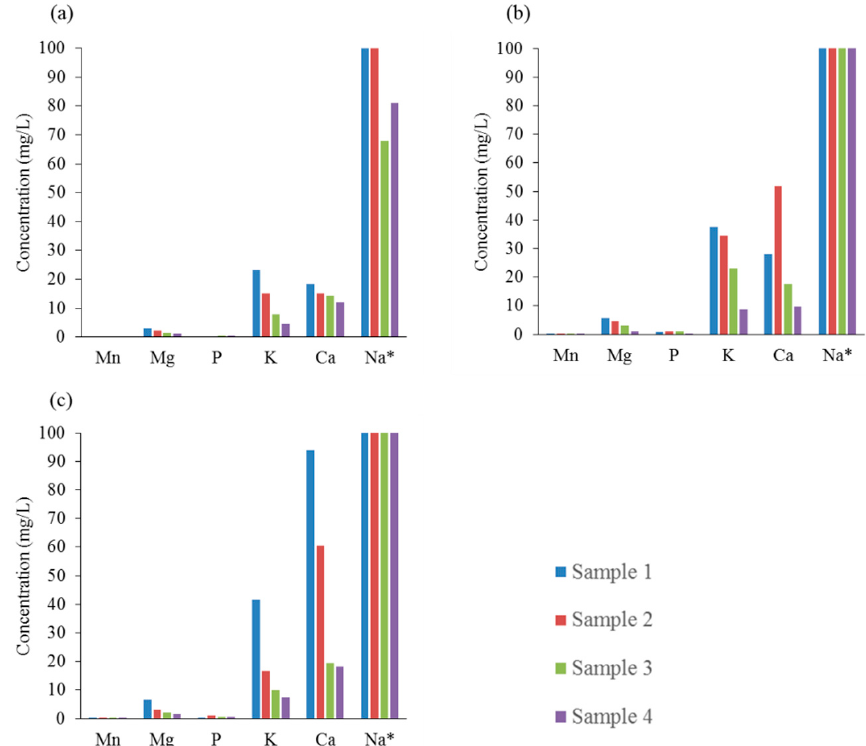
Figure 5. Effect of HTC on the Inorganic Composition of the Process Liquid Samples at Different Reaction Temperatures: ( a ) 190 °C; ( b ) 220 °C; ( c ) 250 °C. * Upper detection limit for sodium was 100 mg/L.